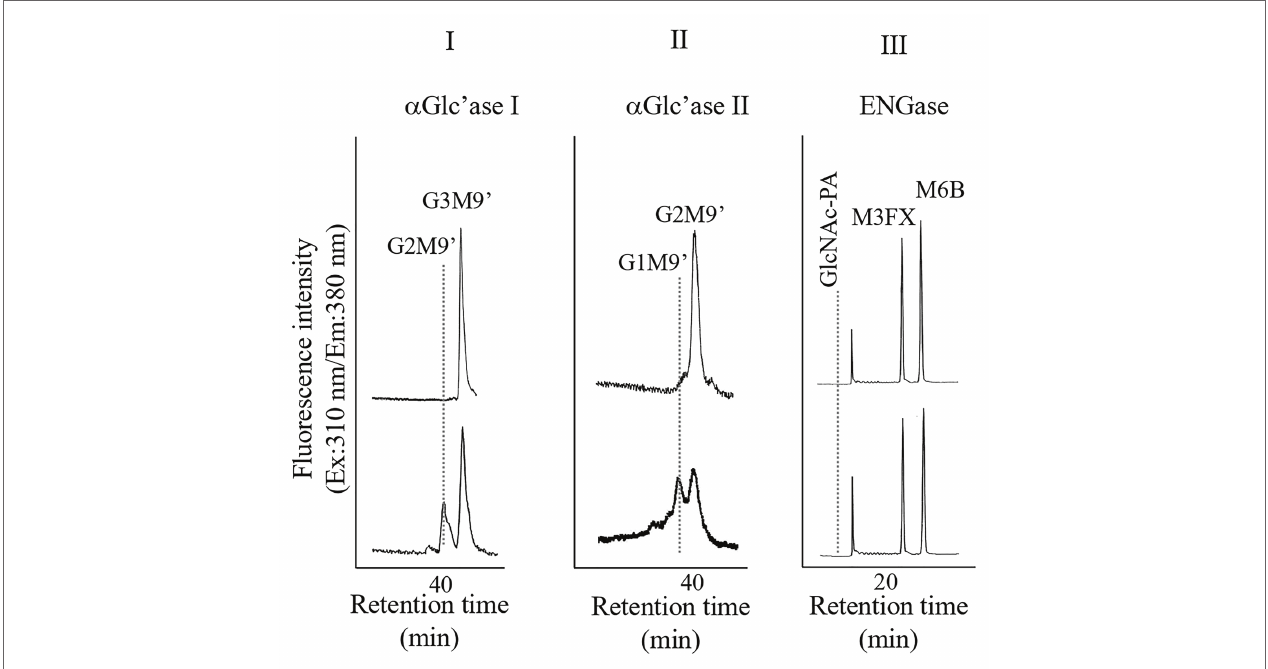
FIGURE 1 | High performance liquid chromatography (HPLC) analyses of α -glucosidase I (I) and II (II) and endo- β - N -acetylglucosaminidase (ENGase; III) activities of the microsomes obtained from pumpkin hypocotyls α -Glc’ase I and II activities were assayed using Glc 3 Man 9 GlcNAc 1 -PA (G3M9’) and Glc2Man9GlcNAc1-PA (G2M9’), respectively, as substrates. The reaction mixtures were analyzed by size fractionation (SF)-HPLC, using a Shodex Asahipak NH2P-50 4E column. The ENGase activity was assayed using Man 6 GlcNAc 2 -PA (M6B) as a substrate and Man 3 Xyl 1 Fuc 1 GlcNAc 2 -PA (M3FX) as an internal standard. The reaction mixture was analyzed by reversed-phase (RP)-HPLC, using a Cosmosil 5C18-AR-II